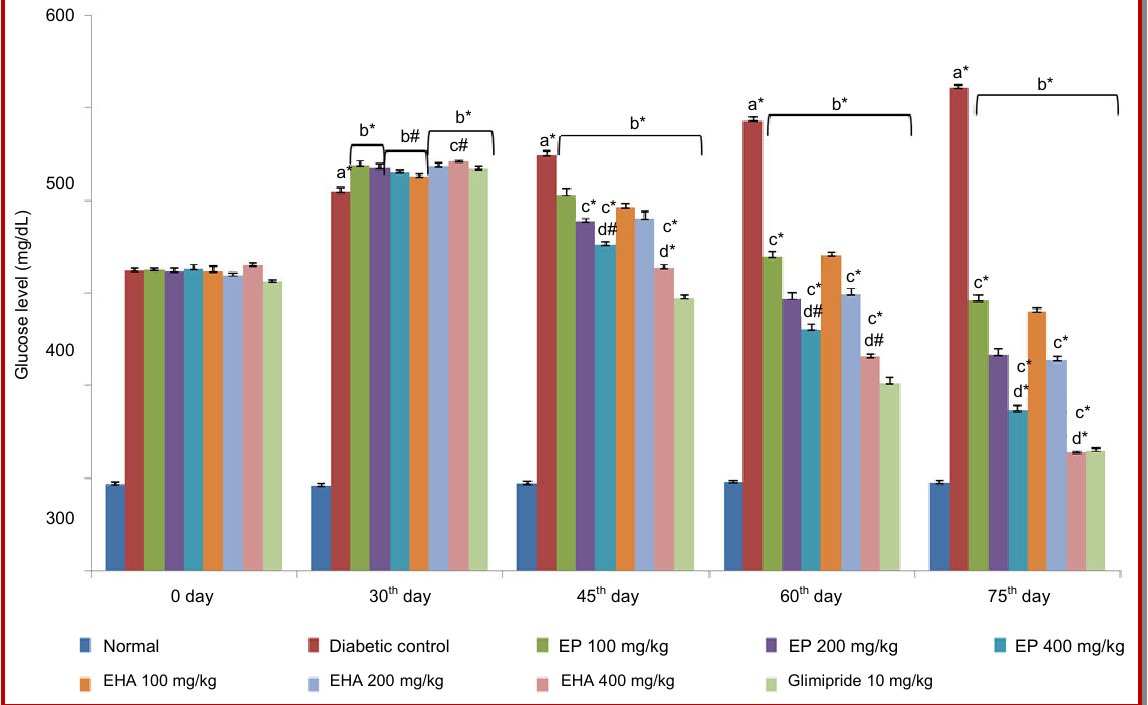
Figure 2: Effect of petroleum ether (EP) and hydroalcohol (EHA) extract on blood glucose level. Data are mean ± SEM; n = 6; Data was analyzed by using one- way ANOVA followed by Tukey’s multiple test; ‘a’ vs control, ‘b’ vs diabetic control, ‘c’ vs E. sativa p<0.001, # p<0.01, † p extract 100 mg/kg, ‘d’ vs E. sativa extract 200 mg/kg; ∗